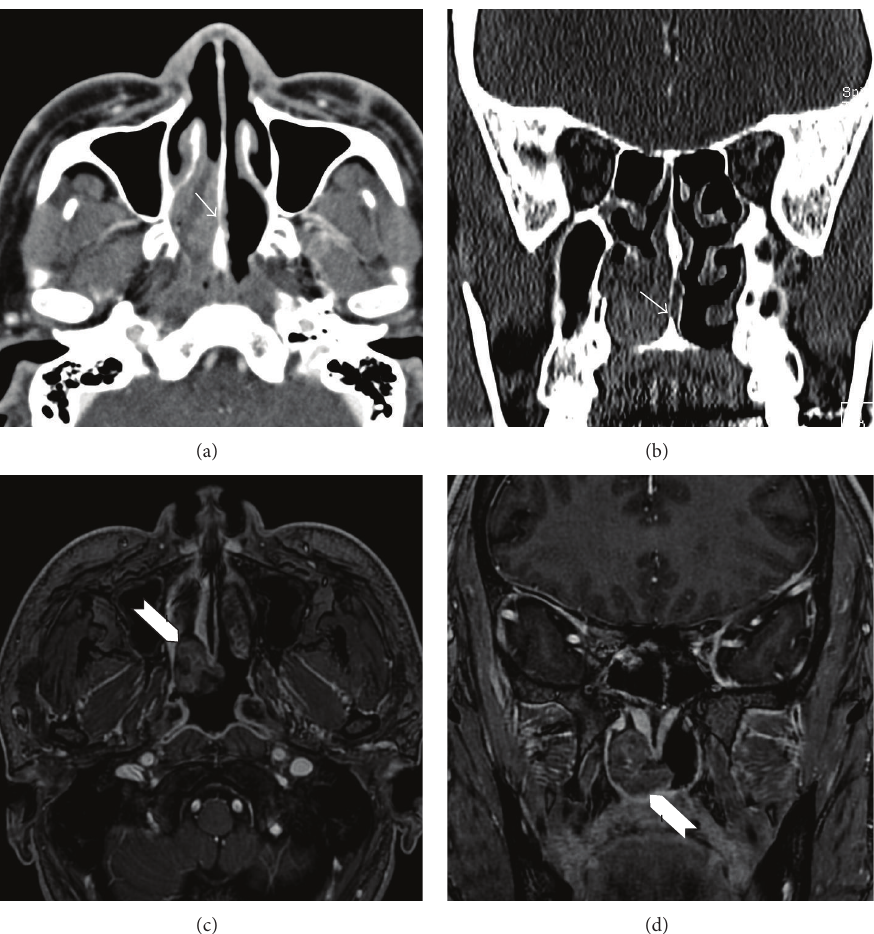
Figure 1: Axial (a) and coronal (b) images of paranasal sinus computed tomography. The mass shows a heterogeneous density between the nasalseptumandlateralnasalwall,witherosionoftheseptalbone(arrow).Axial(c)andcoronal(d)imagesofparanasalsinusT1-gadolinium- enhanced magnetic resonance imaging. A 2.5 × 1.5 cm sized, gadolinium-enhanced fungating mass with internal hemorrhage, and vascularity (arrowhead) can be seen between the right choana and lateral wall. The lesion is well demarcated with smooth